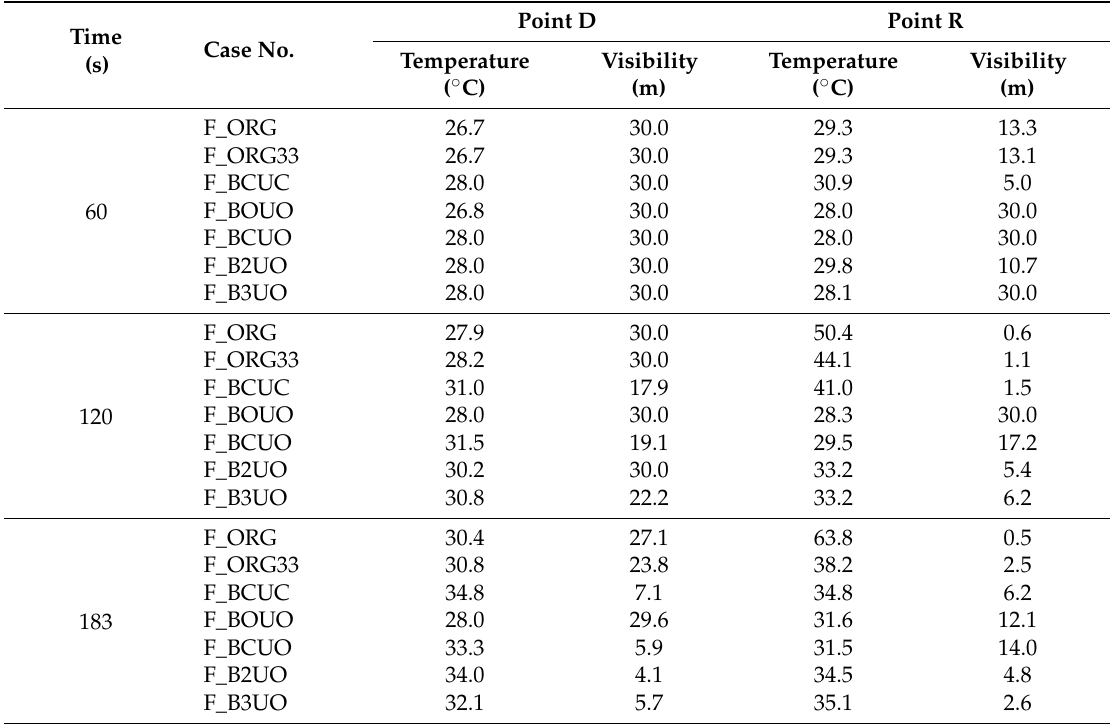
Table 6. The situation of Point D and R in various